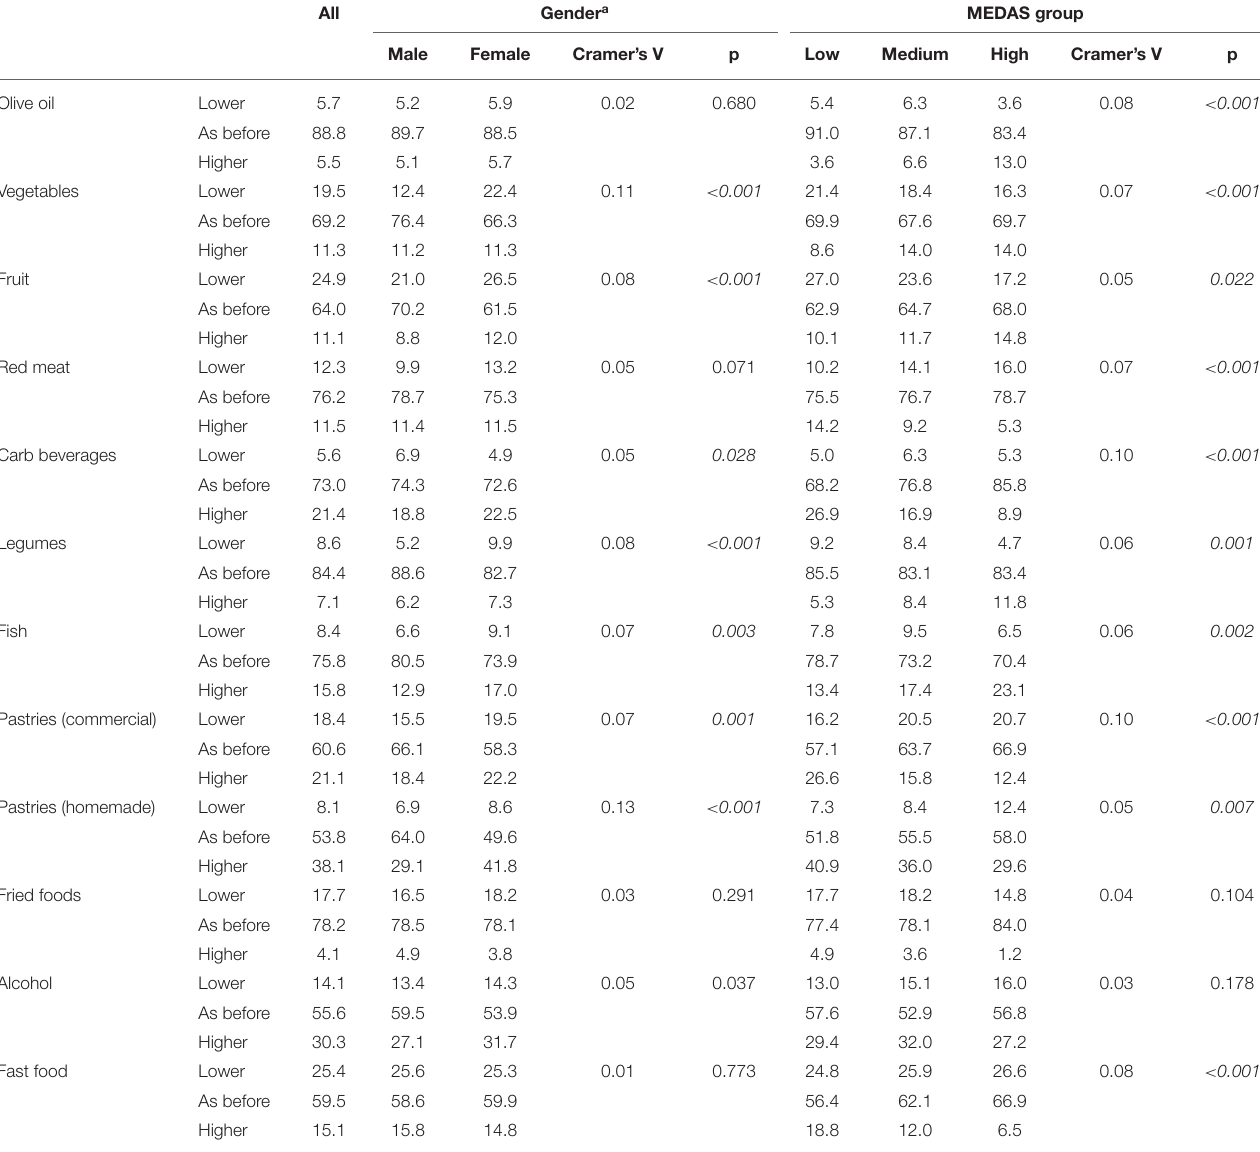
TABLE 3 | Reported changes (%) in general dietary habits and physical activity level during lockdown, at an overall level as well as by gender and adherence to MedDiet, with associated χ 2 p